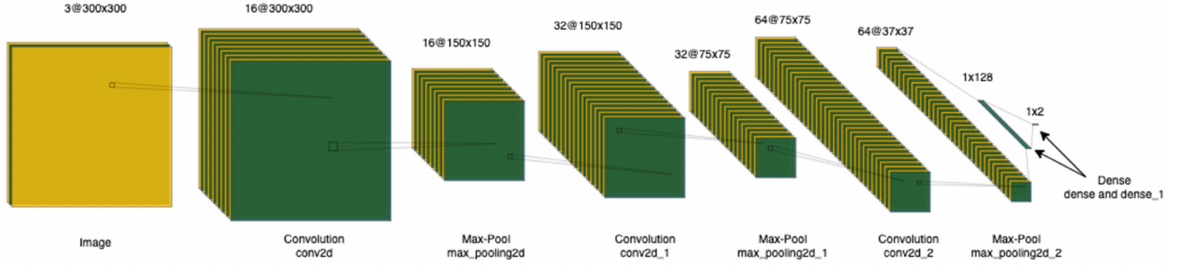
Figure 5. CNN architecture for Smart Quality